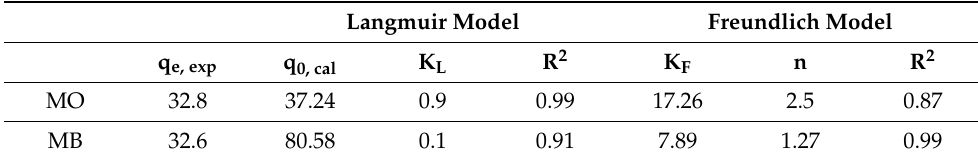
Table 1. Parameters of Langmuir and Freundlich Models and R 2 for MO and